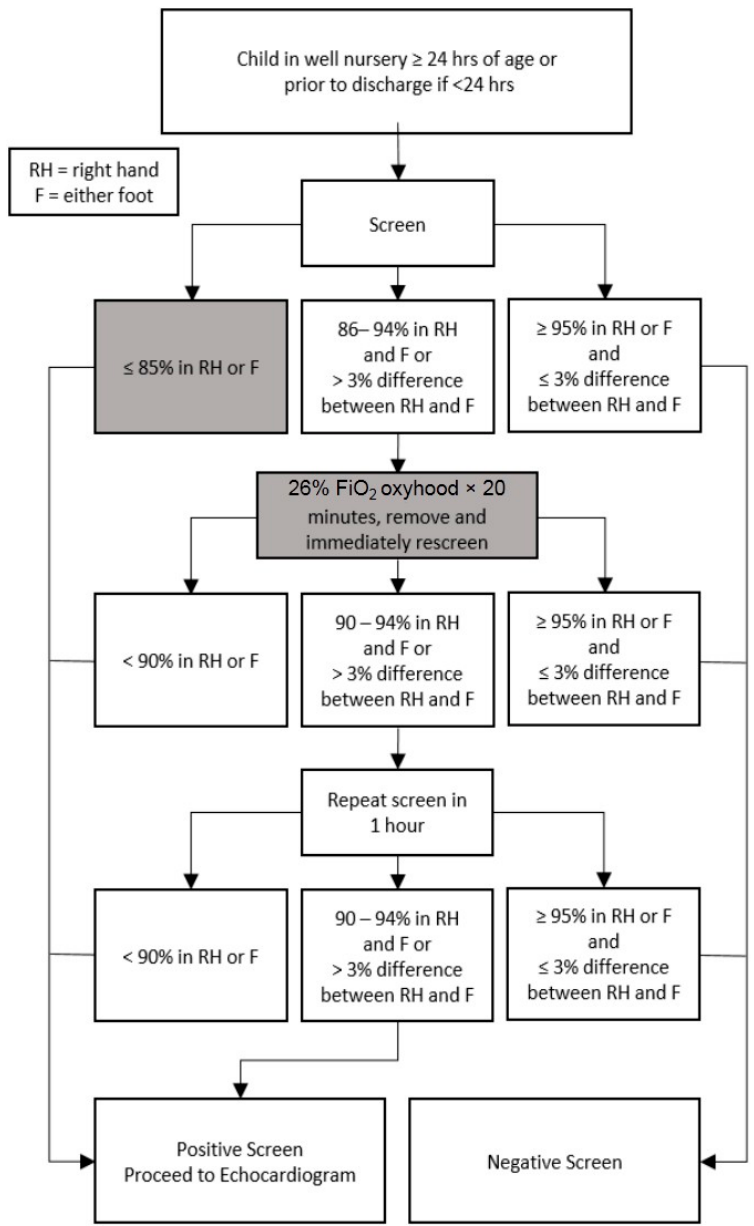
Figure 2. Modified critical congenital heart disease (CCHD) screening protocol. Our modified CCHD screening protocol with deviations from the American Academy of Pediatrics (AAP) protocol highlighted. Modifications, indicated by gray boxes, include a decreased first screen saturation cutoff from 90% to 85% as well as the oxygen hood intervention between the first and second screens.